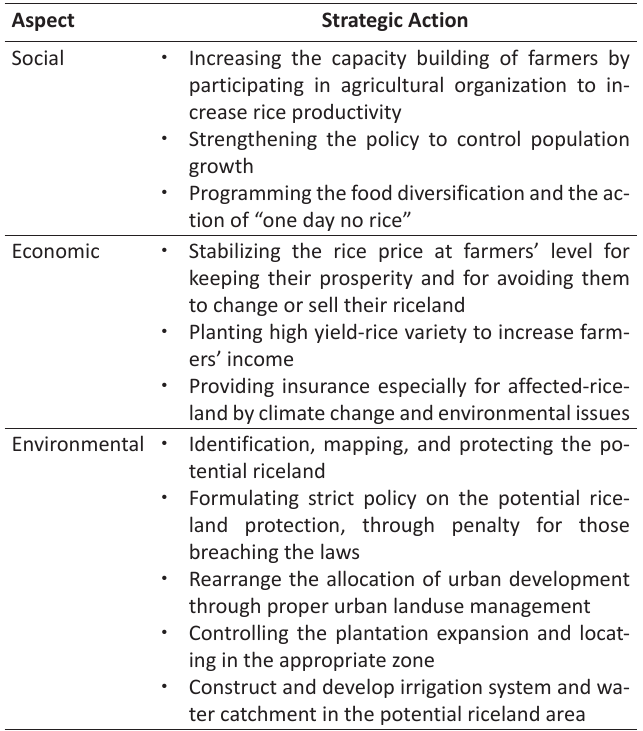
Table 3 . Some strategic actions to achieve the sustainability on rice